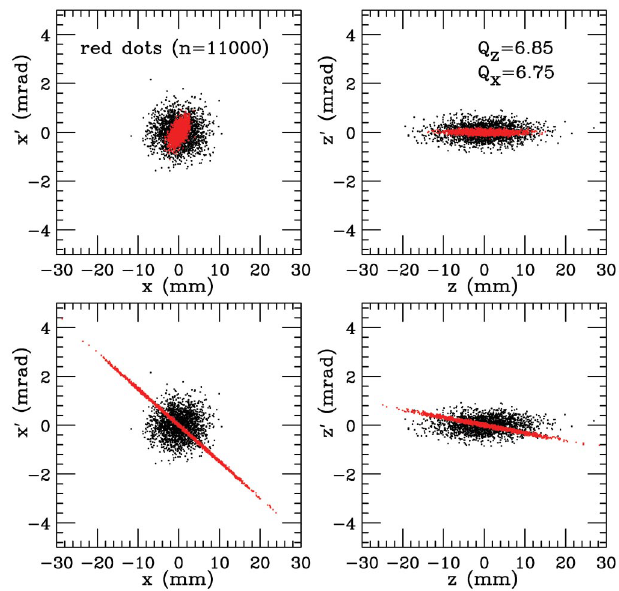
FIG. 29. (Color) The beam phase-space distribution for the initial (black dots) and the final (red dots at n (cid:5) 11 000 revolution or a kinetic energy of 5.0 GeV) distributions for a beam with 12-turn injection. Top: The initial (black dots) and the final (red dots at n (cid:5) 11 000 revolution) phase-space (cid:5) 4 : 0 (cid:2) 10 (cid:1) 4 m (cid:1) 1 . Bottom: plots (cid:3) x; x 0 (cid:4) and (cid:3) z; z 0 (cid:4) for the A b 1 The same as that of the top plot except the amplitude of the (cid:5) 4 : 0 (cid:2) 10 (cid:1) 3 m (cid:1) 1 random quadrupole error is A b 1